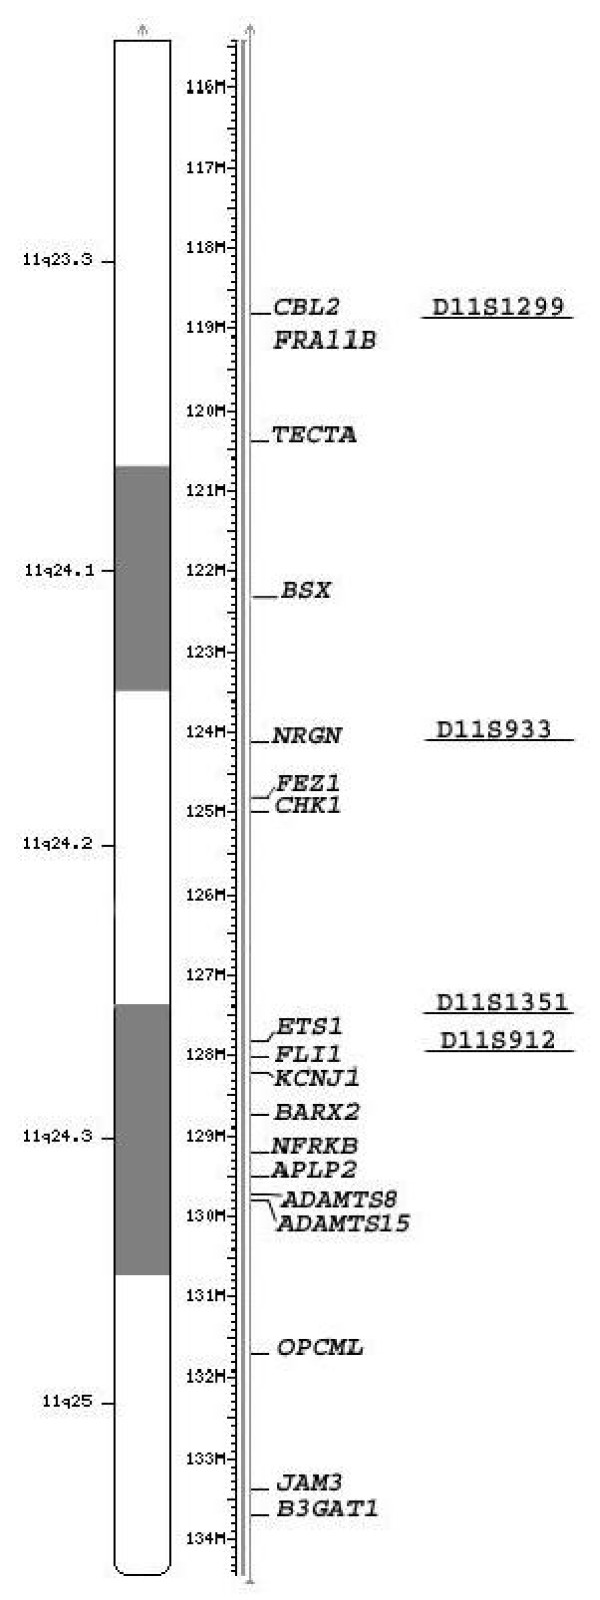
11q23.3-qter. From left to right: ideogram, megabase position (Mb), most relevant genes, markers. The position of genes and markers is from UCSC the human march 2006 assembly [32].